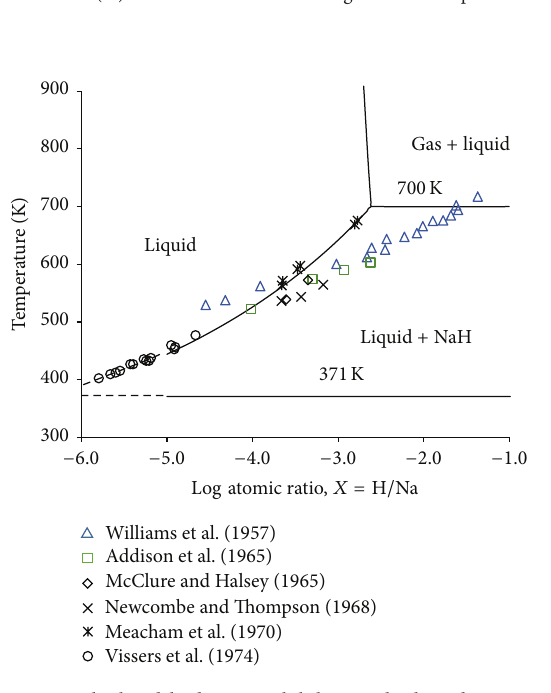
Figure 6: Calculated hydrogen solubility in the liquid Na system at 1-bar pressure in comparison to the experimental data in the literature [59–64].